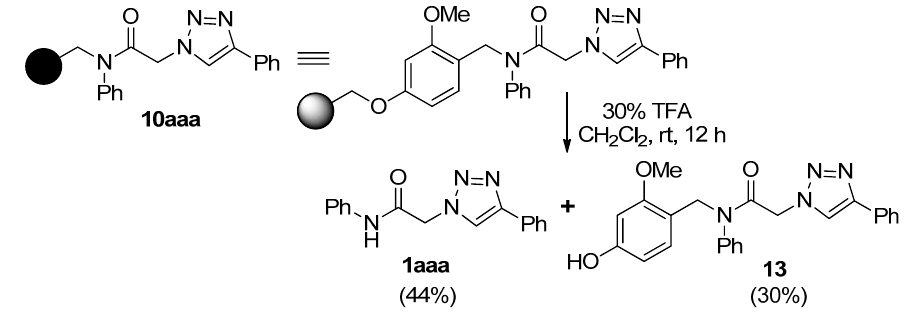
Figure 5. ATR-FTIR spectra of resins 3 , 4 , 7 , 8 and 10 (R 1 = R 2 = Ph, A = CH 2 ).